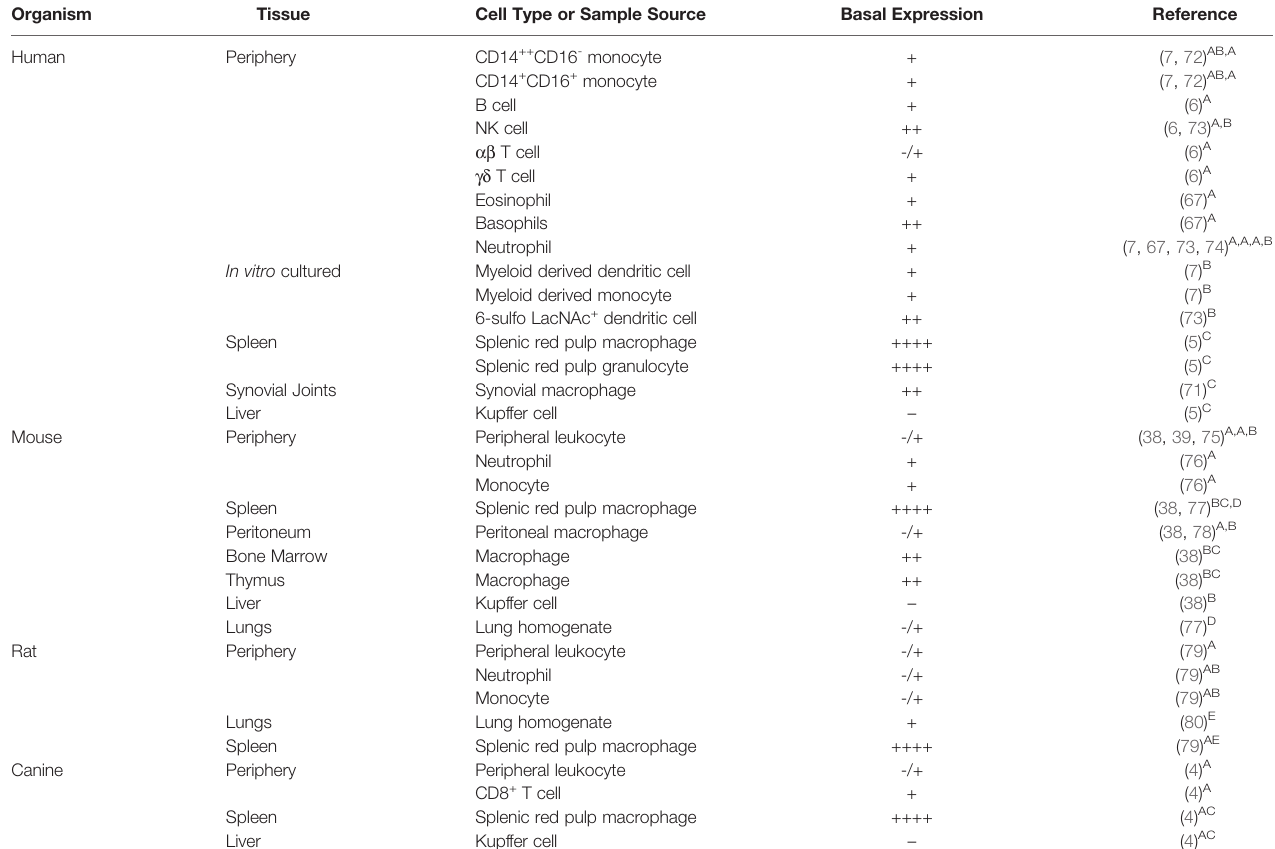
TABLE 1 | Basal CD11d expression amongst leukocytes of various